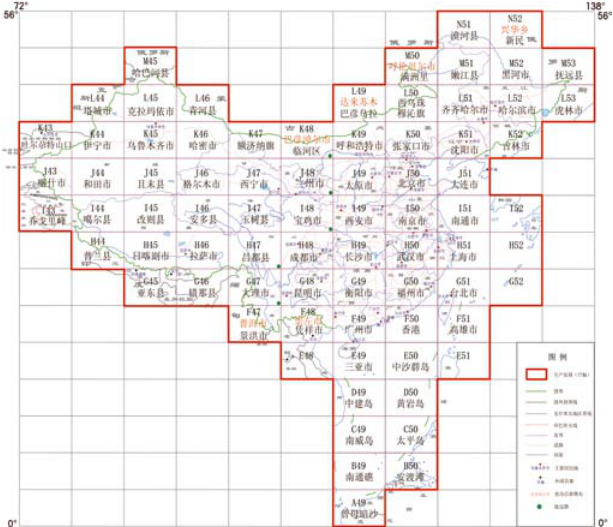
Figure 1. Data range of 1:1000000 topographic